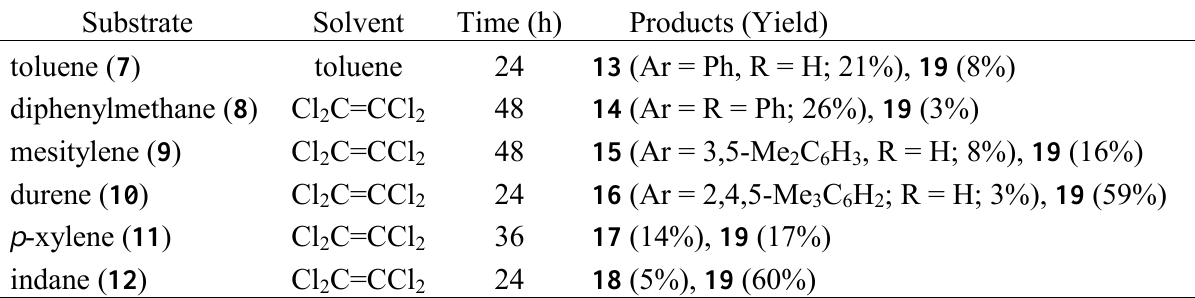
Table 1. The reactions of alkyl benzenes with o -chloranil ( 3 ) under reflux conditions.